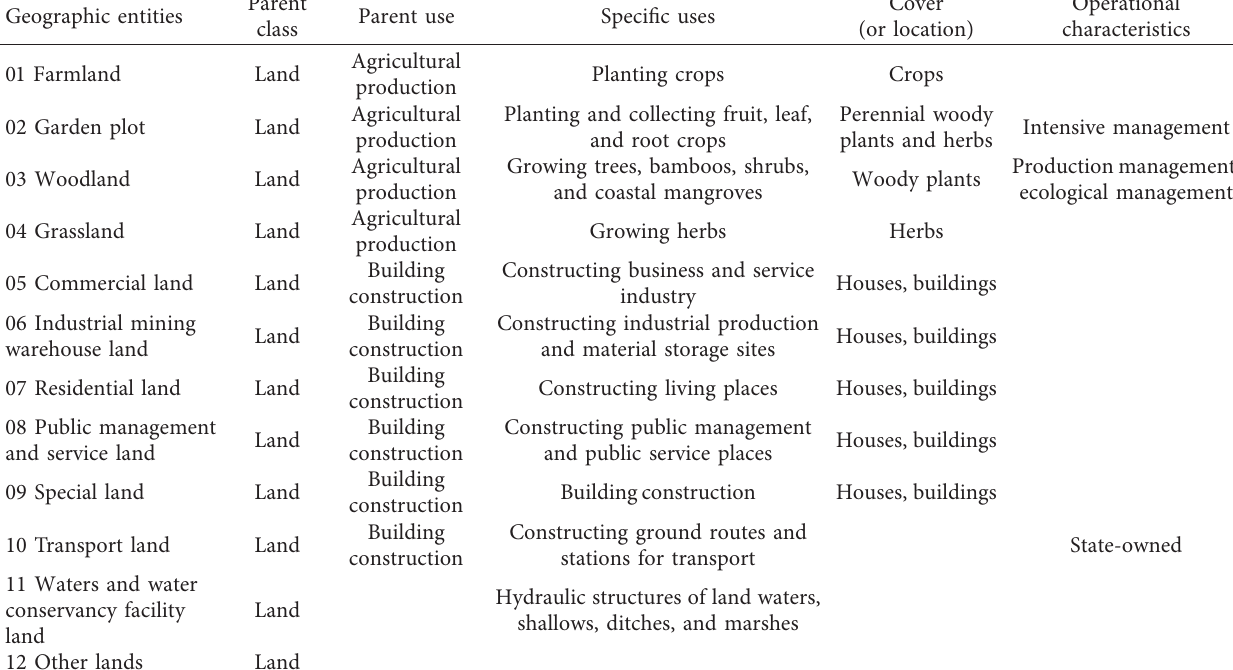
Table 1: Part attributes of geographical entity in land-use type